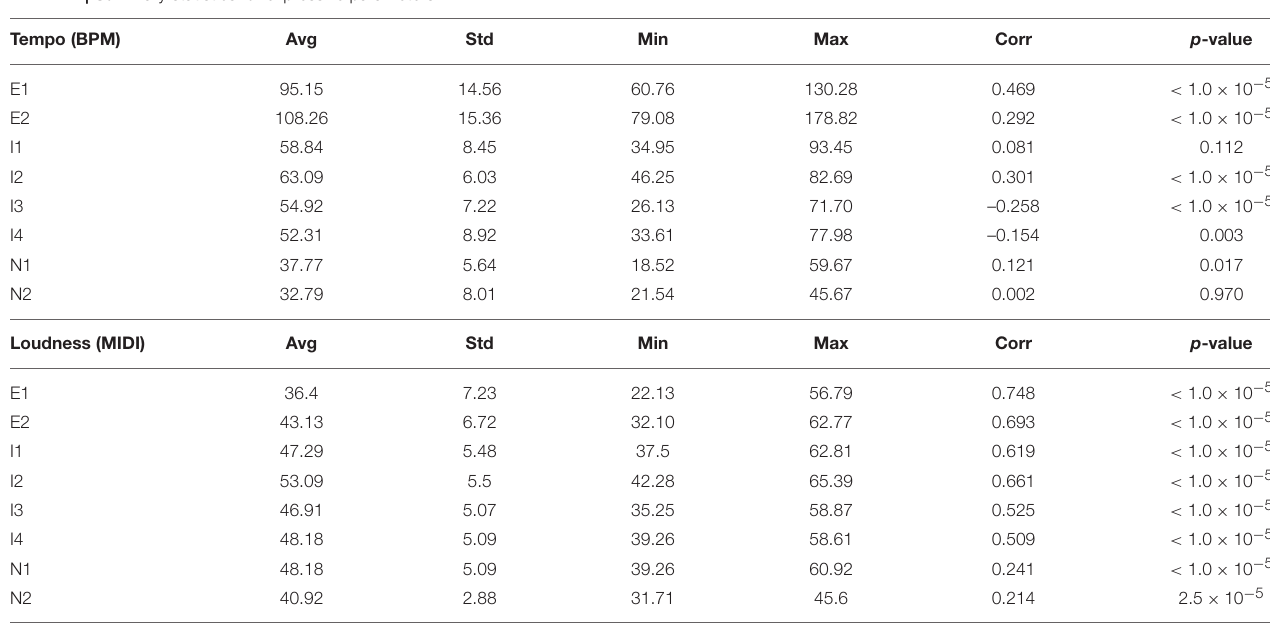
The p -values in the right-most column in Table 1 show the loudness correlations of all participants, and the tempo correlations of almost all participants, to be